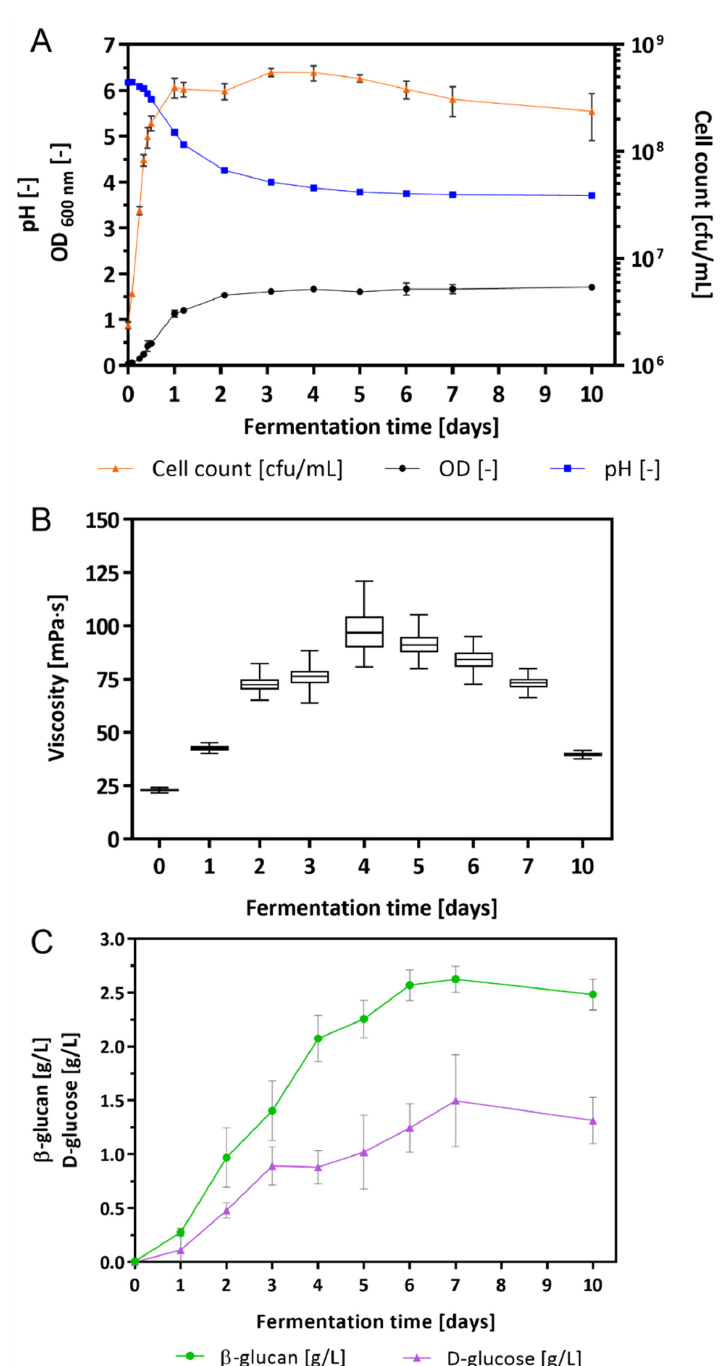
Figure 1. Growth characteristics of the fermentation broth: ( A ) cell count in cfu/mL, OD, and pH, ( B ) changes in the viscosity, and ( C ) β -glucan and D-glucose concentration in culture supernatants. Values are mean values of four-fold biological replicates including standard deviations.